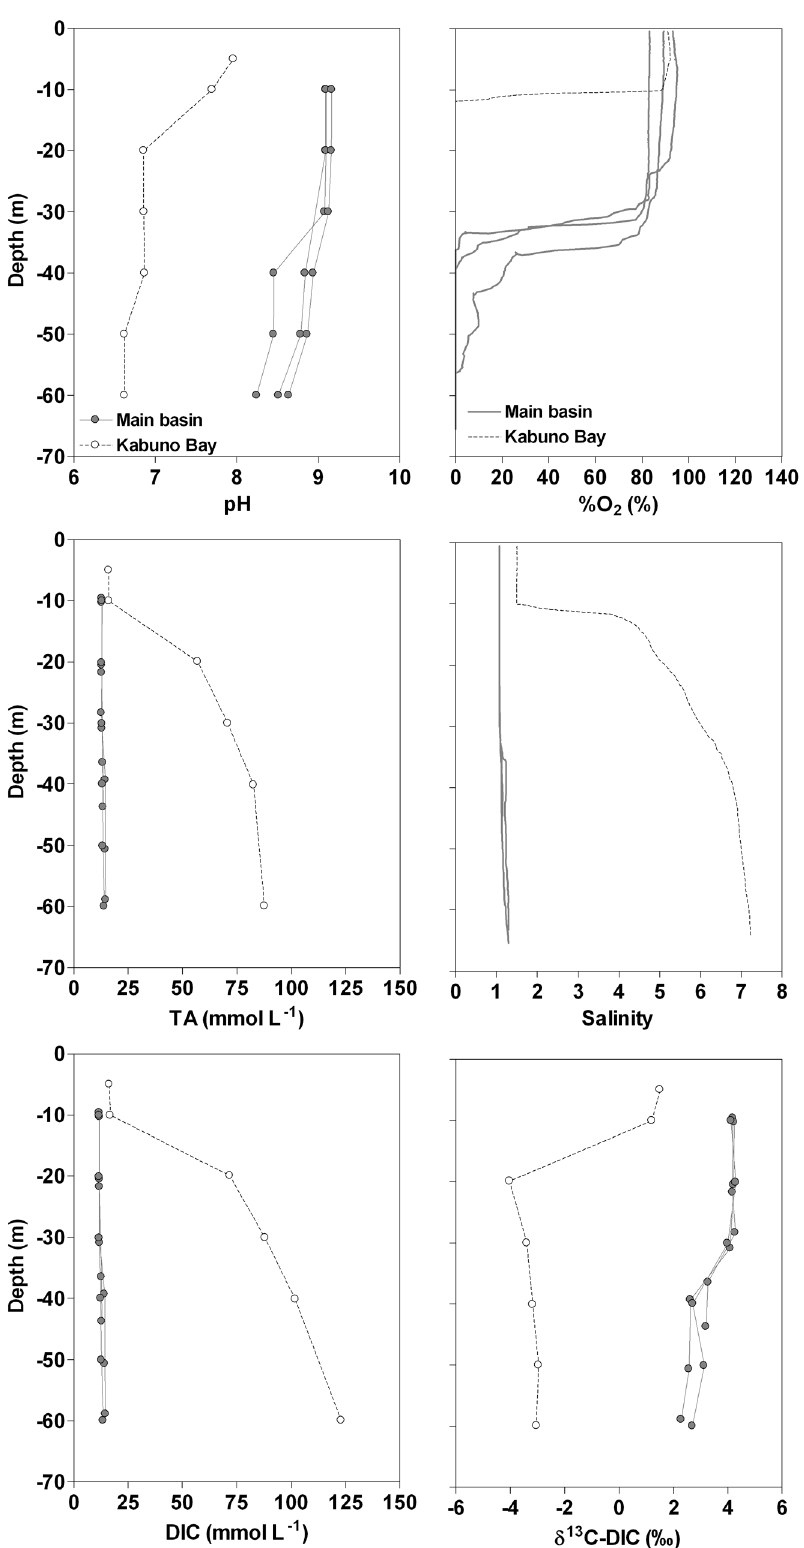
Figure 3. Vertical profiles in March 2007 of pH, oxygen saturation level (%O 2 , %), total alkalinity (TA, mmol L 2 1 ), salinity, dissolved inorganic carbon (DIC, mmol L 2 1 ), d 13 C signature of DIC ( d 13 C-DIC, % ) in Kabuno Bay and in the three northernmost stations in the main basin of Lake Kivu.